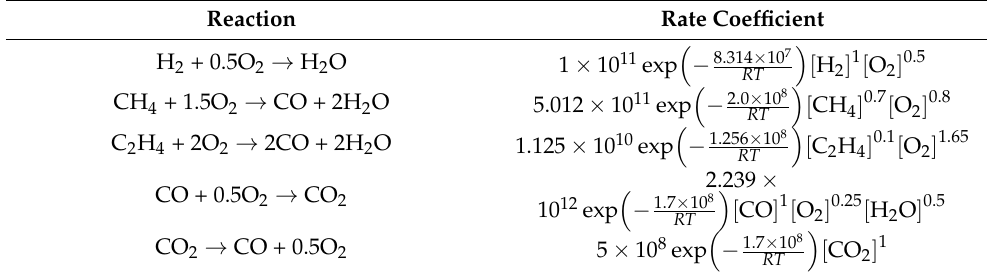
Table 1. Chemical reaction mechanism of the venting gas.